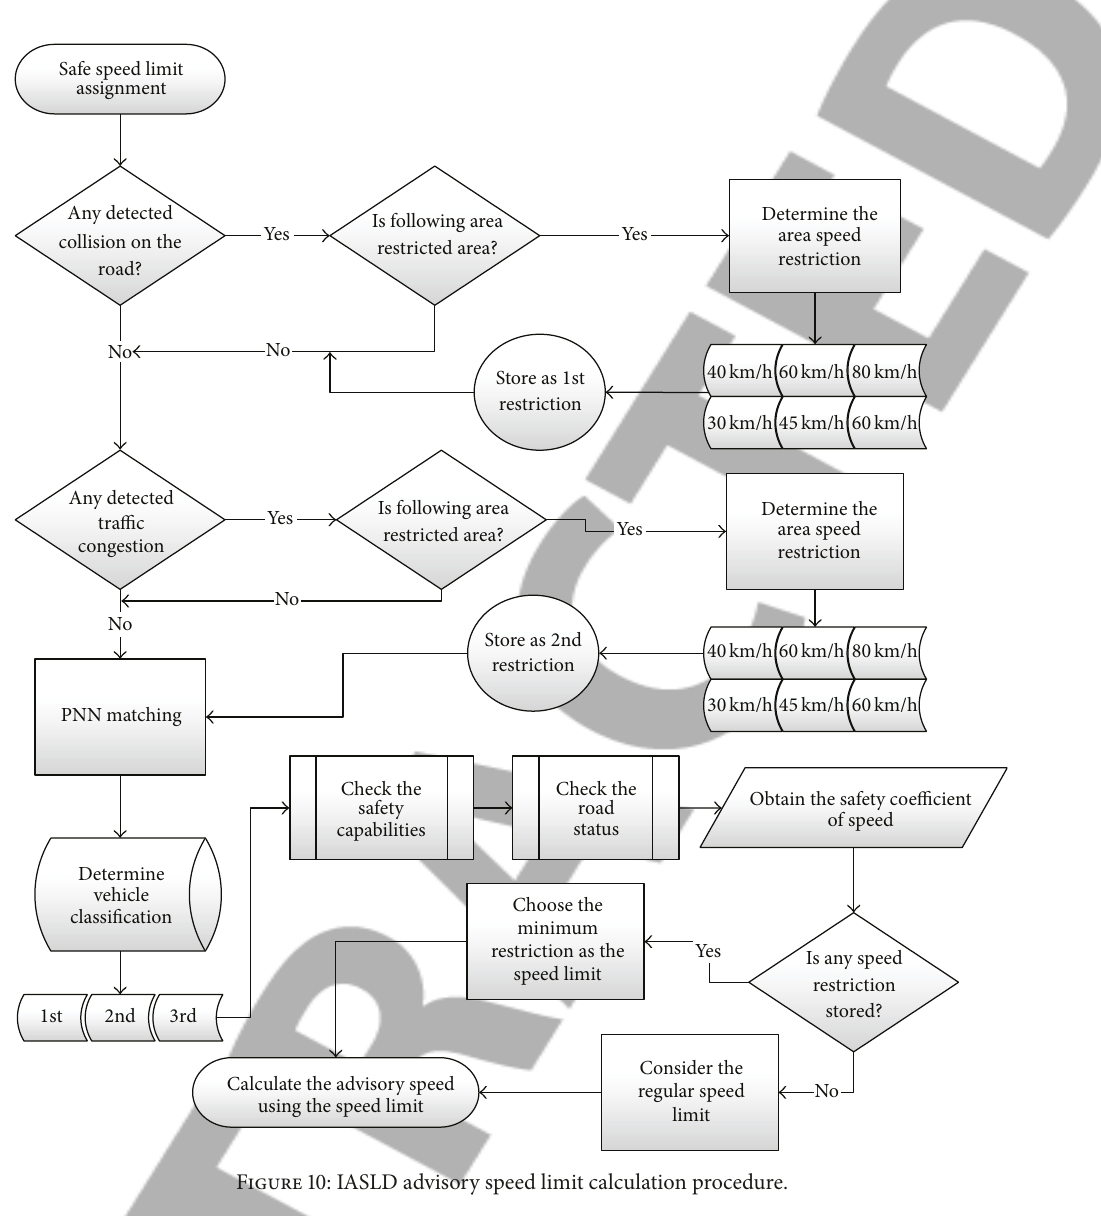
Figure 10: IASLD advisory speed limit calculation